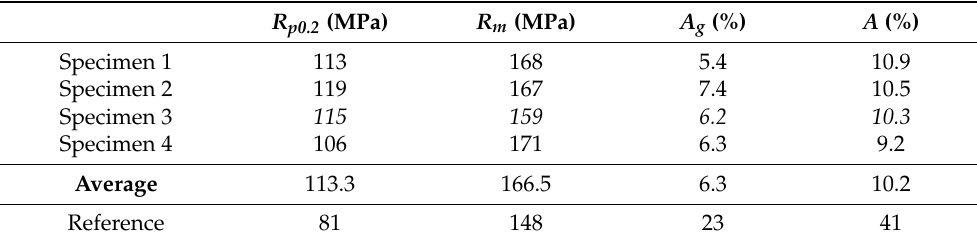
Table 2. Mechanical properties of the recycled wires and the average value of the reference speci- men in comparison.